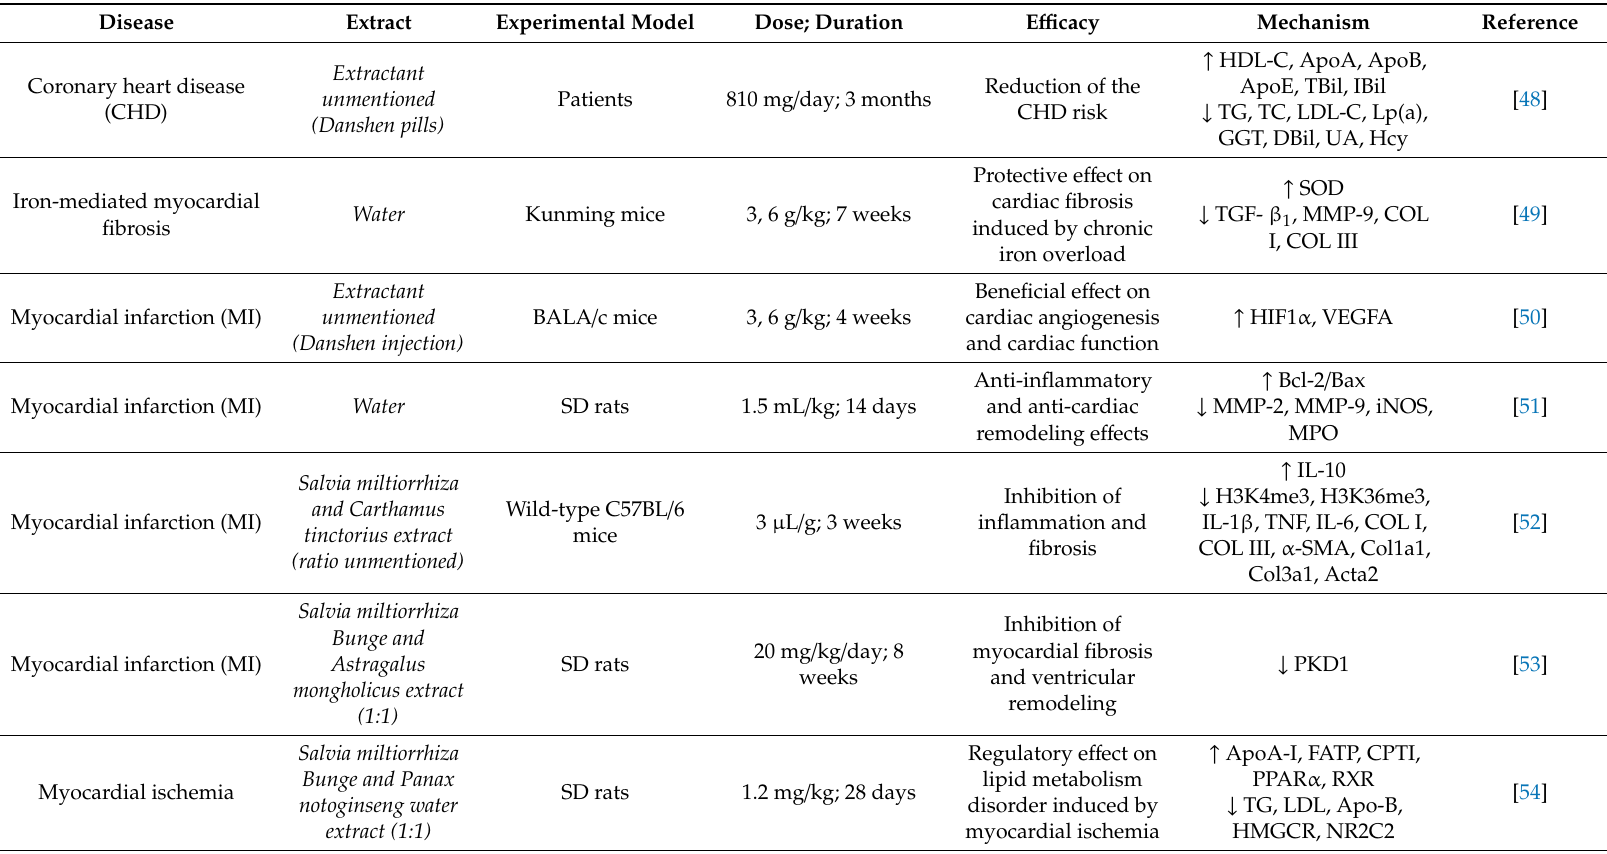
Table 2. Cardiovascular diseases and S.